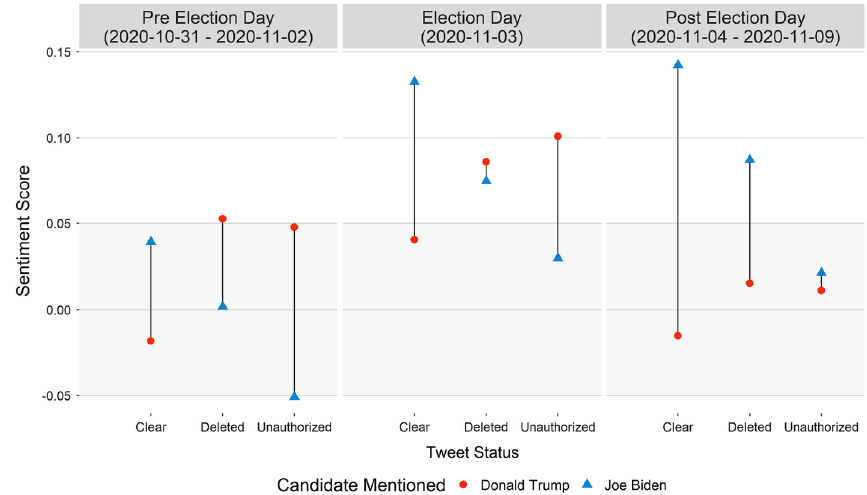
Fig. 6 Average sentiment scores of tweets that mentioned either candidate grouped by tweet status type, before, during, and after Election Day. For each tweet status type, a straight line is drawn to highlight the difference between the sentiment scores for each candidate. They gray shaded region in the plots represents the neutral sentiment area. Tweets that mentioned both candidates are